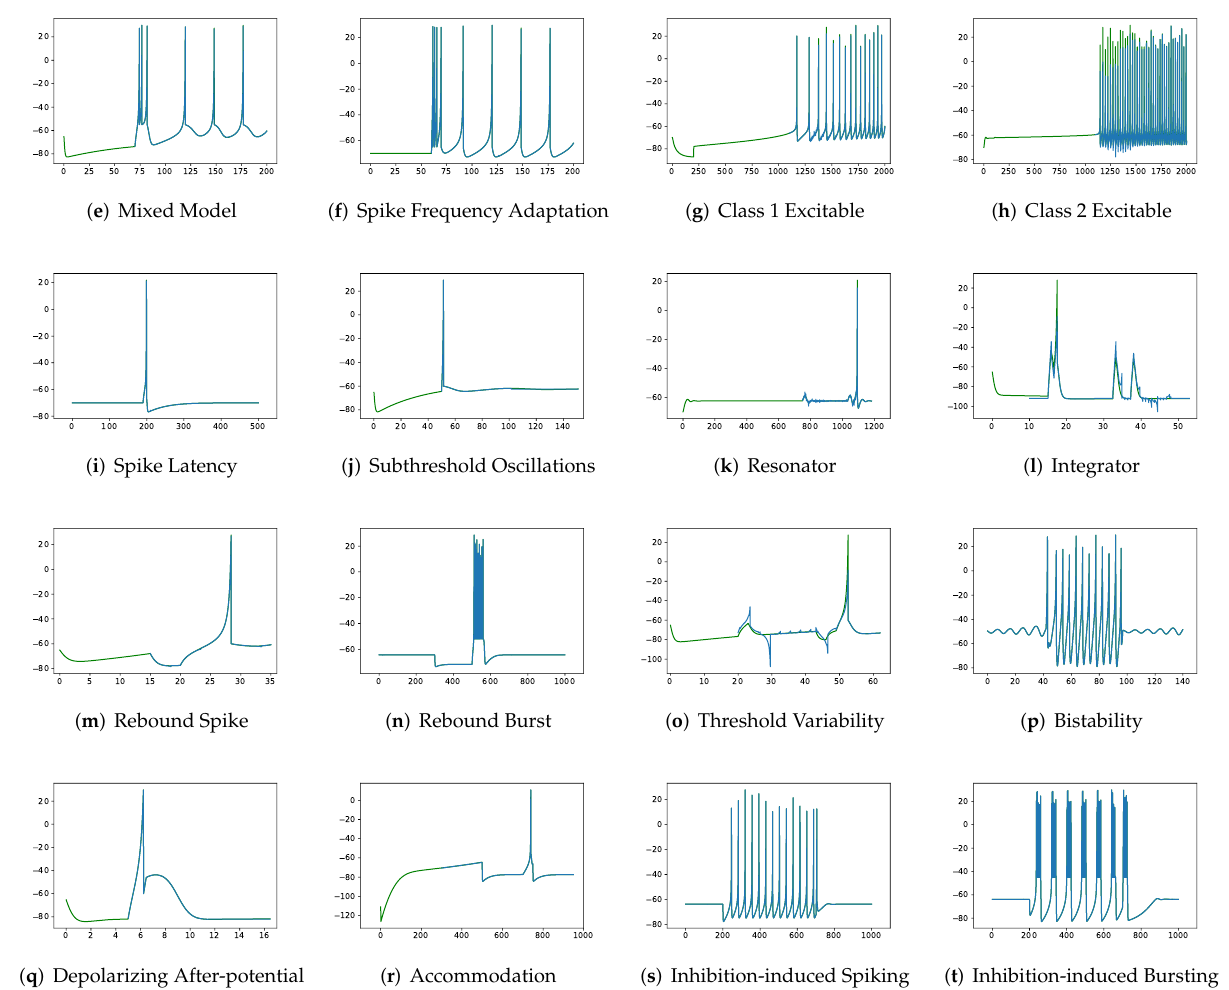
Figure 2. Membrane potentials of SRM (blue) vs. Izhikevich Model (green), where y-axis is the membrane potential (mV) and x-axis is the time (ms).